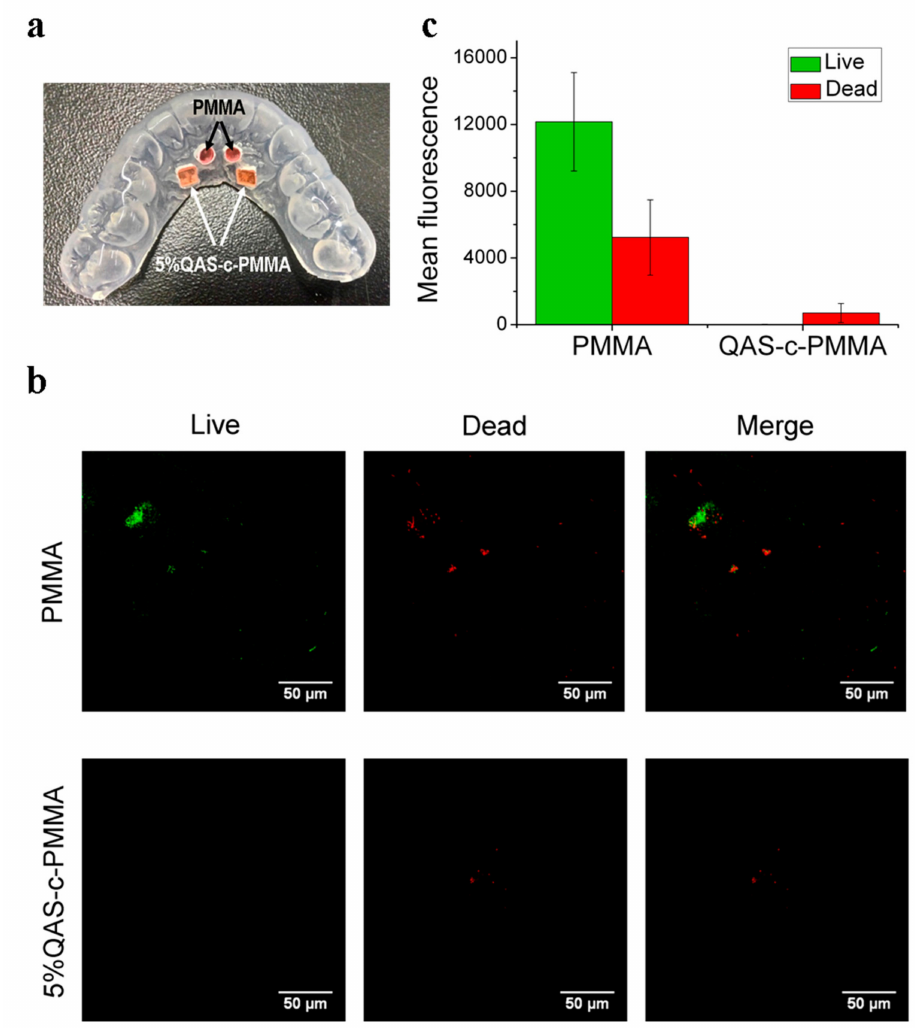
Figure4. Confocallaserscanningmicroscope(CLSM)live / deadfluorescentstainingtests: ( a )Removable acrylic appliance holding two PMMA and two 5%QAS-c-PMMA discs; ( b ) CLSM images obtained from PMMA (top row) and 5%QAS-c-PMMA (bottom row) discs with dead bacteria fluorescing red from propidium iodide (PI) staining and live bacteria fluorescing green from SYTO 9 staining; ( c ) the total cell fluorescence of the stained cells averaged over the CLSM images, after correction against the mean fluorescence of background readings in the area of the selected cells, obtained from all PMMA and 5%QAS-c-PMMA